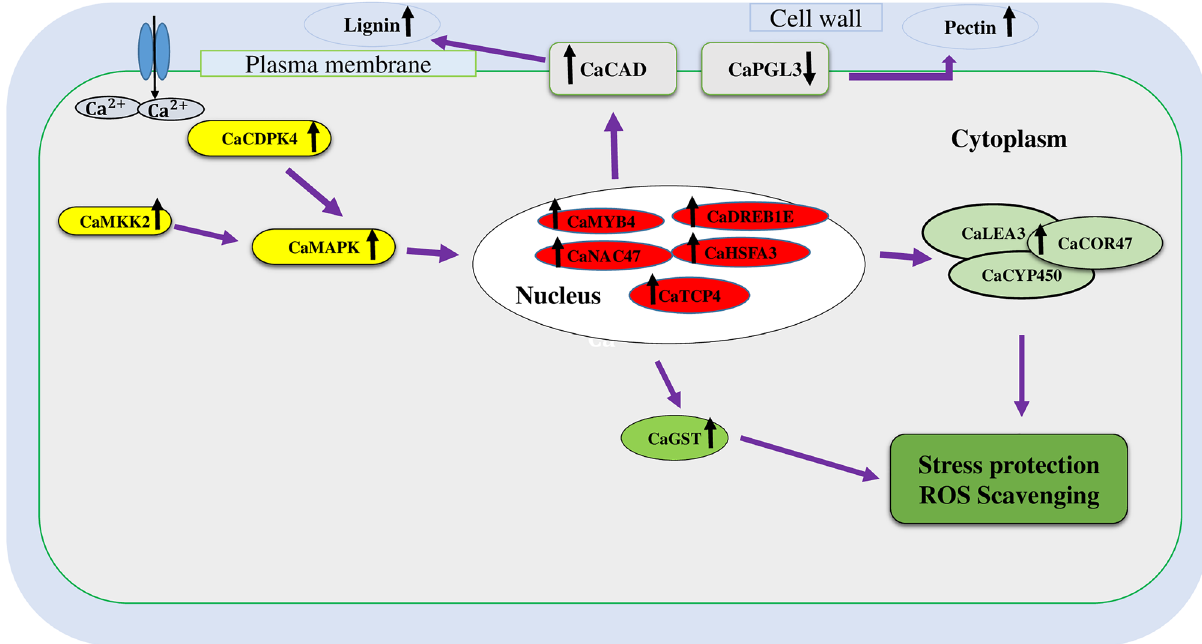
Figure 5. Proposed model for cold tolerance in a tolerant cultivar of chickpea, saral. Yellow and red colors were utilized to depict signaling-associated genes and transcription factors, respectively. White and green colors were used to exhibit genes involved in cell wall modifications and stress-protective and ROS scavenging genes,